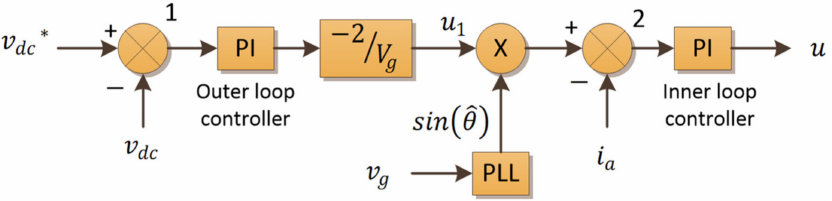
Figure 6. H full bridge converter controller.